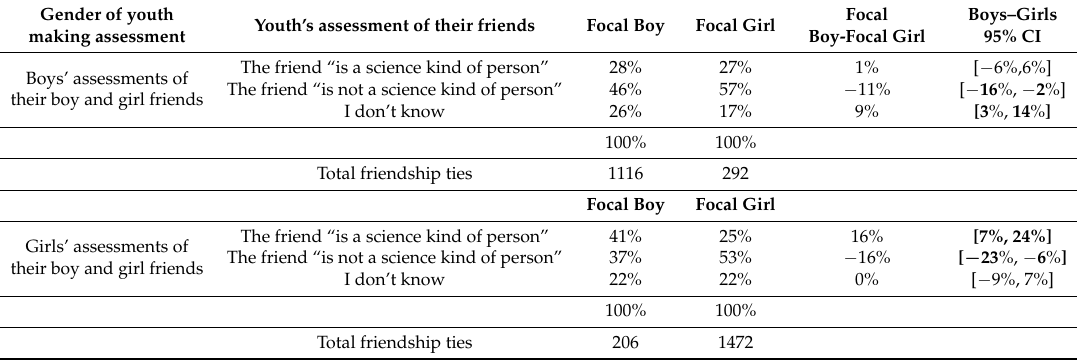
Table 4. Implicit gender associations with science based upon friend assessments of each of their friends (focal peers) as a science kind of person (or not a science kind of person) by the gender of the assessor and the gender of the focal